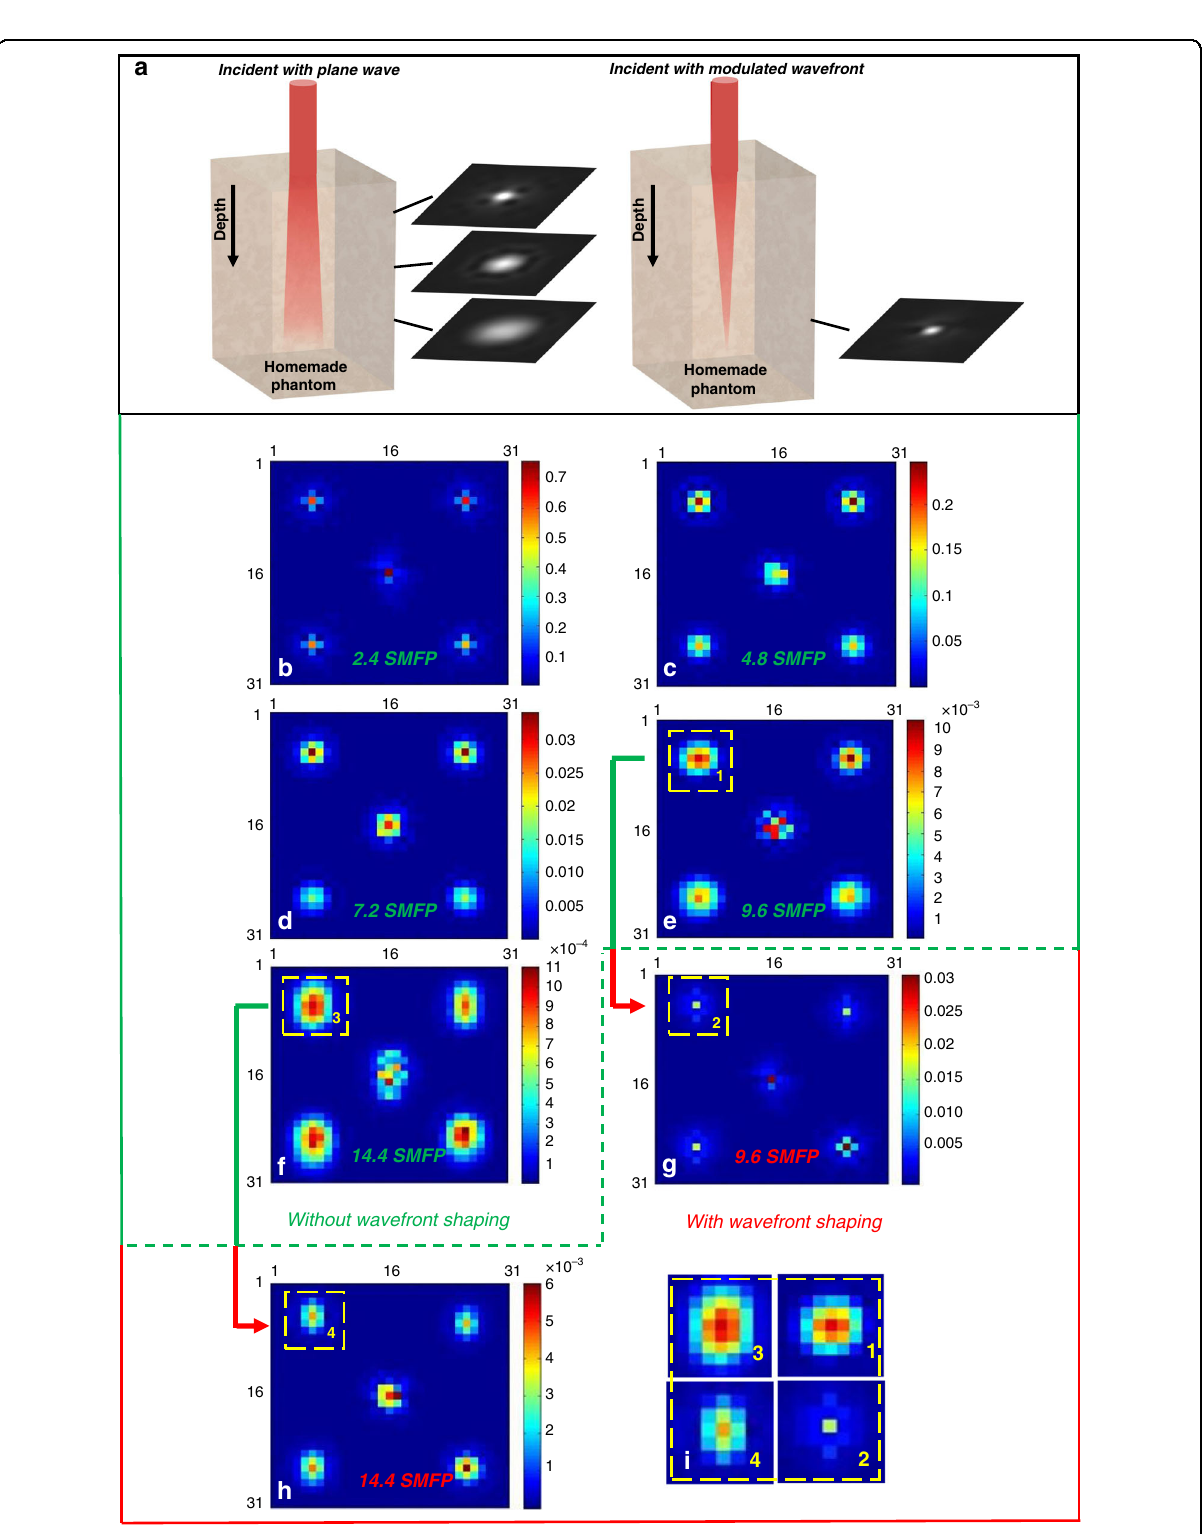
Fig. 3 Wavefront shaping helps focus a beam deep inside the homemade phantom. a When illuminating the phantom with a plane wave, the beam becomes more defocused with depth; however, if it is illuminated with matched wavefront, the beam can achieve focus even deep inside the phantom. b – f show the beam intensity patterns at the depths of 2.4, 4.8, 7.2, 9.6, and 14.4 SMFP without wavefront shaping. g , h show the beam intensity patterns at the depth of 9.6, and 14.4 SMFP when wavefront shaping is employed. i shows the magni fi ed views of areas enclosed by yellow dashed lines in ( e – h ). The color scale bar is the normalized relative